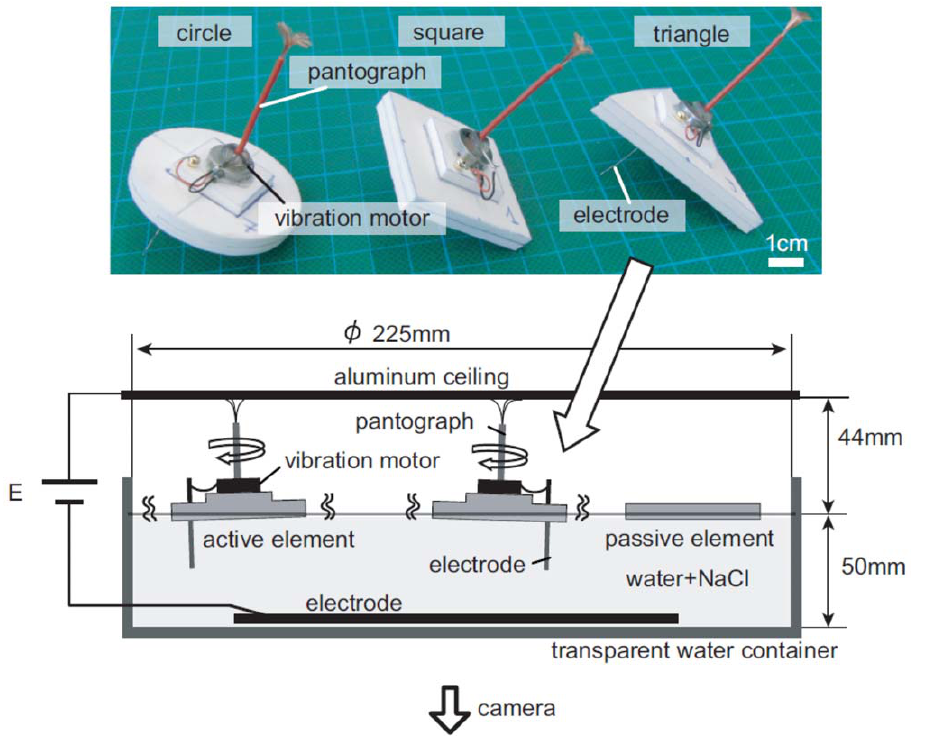
Figure 1. Schematics of experimental setup with three elements. Active elements attain self-agitation by vibrating the vibration motor, while passive elements have no motors.